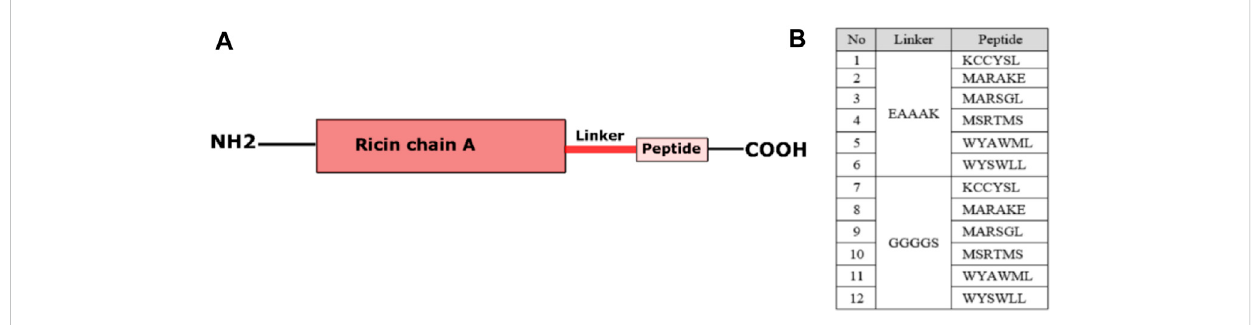
FIGURE 2 The overall view of the 12 designed chimeric protein